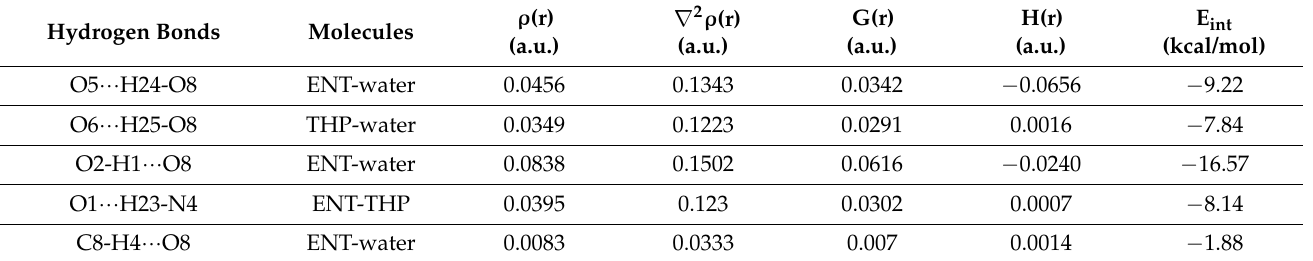
Table 2. QTAIM-calculated properties at selected bond critical points: electron density ( ρ (r)), Lapla- cian of electron density ( ∇ 2 ρ (r)), Lagrangian kinetic energy (G(r)), electronic energy density (H(r)) and the estimated energy of interaction (Eint).